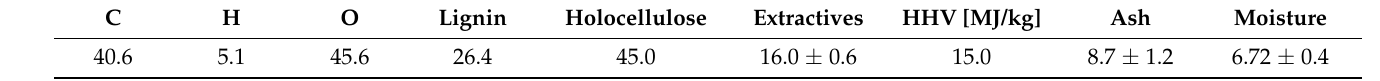
Table 1. Biomass elemental analysis (% on a dry, ash-free basis) and contents (wt%).